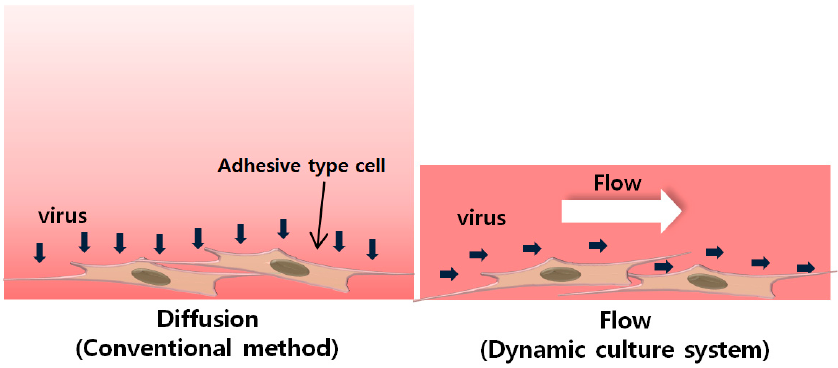
Figure 1. Cells subjected to virus infection by diffusion and flow.